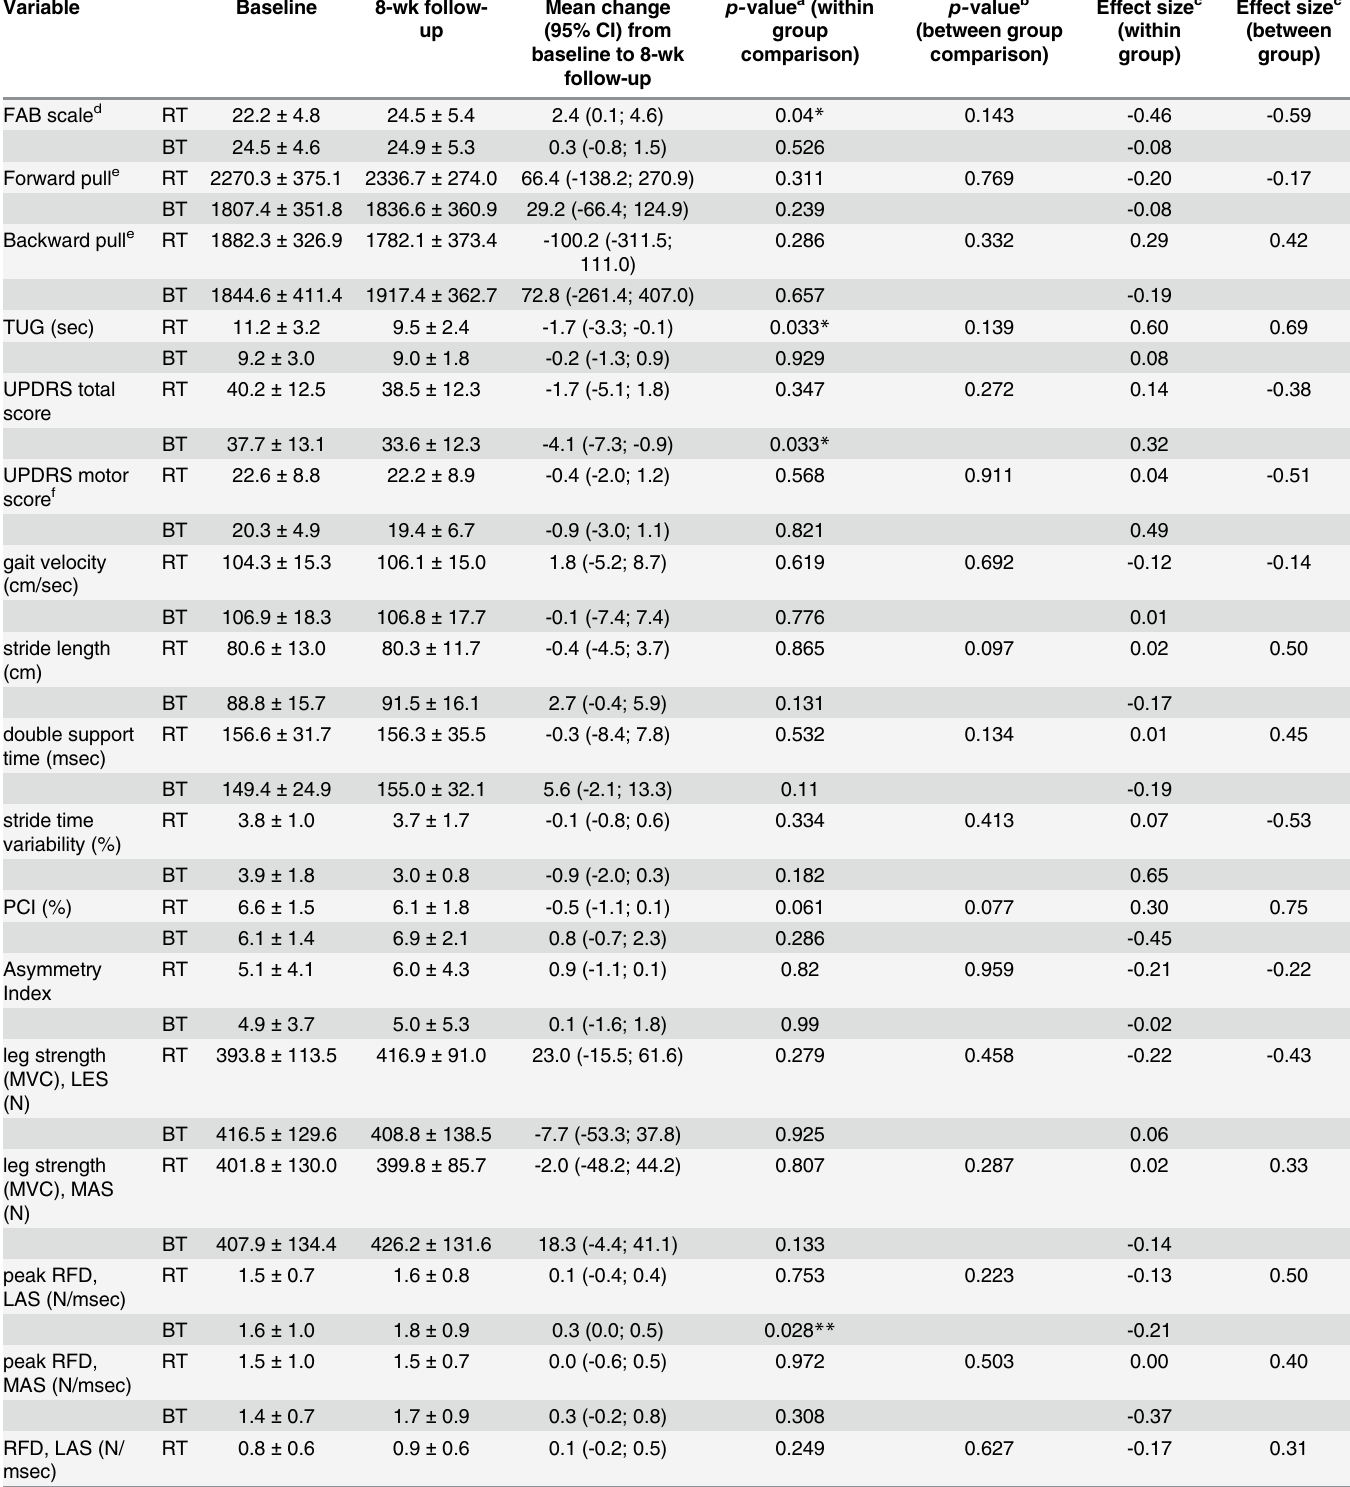
Table 2. Comparison within- and between the two training groups from baseline to 8-weeks follow-up.